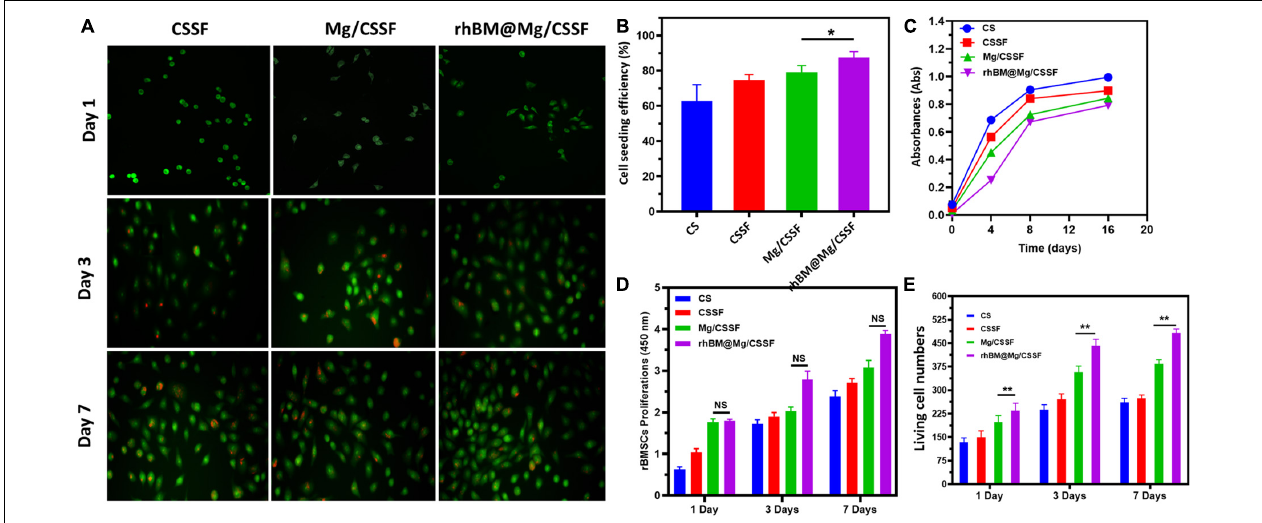
FIGURE 6 | (A) Live/Dead cell morphology and proliferations of the rat bone marrow-derived MSCs (rBMSCs) cultured with prepared hydrogel groups observed under confocal laser scanning microscopy (CLSM) at different incubation times (1, 3, and 7 days). (B) Cell seeding efficiency, (C) cell survival absorbance, (D) proliferation rate, and (E) live cell number of rBMSCs encapsulated in hydrogel groups for different incubation durations. **** p < 0.0001; *** p = 0.0001–0.001; ** p = 0.001–0.01; * p = 0.01–0.05; p ≥ 0.05 means not significant